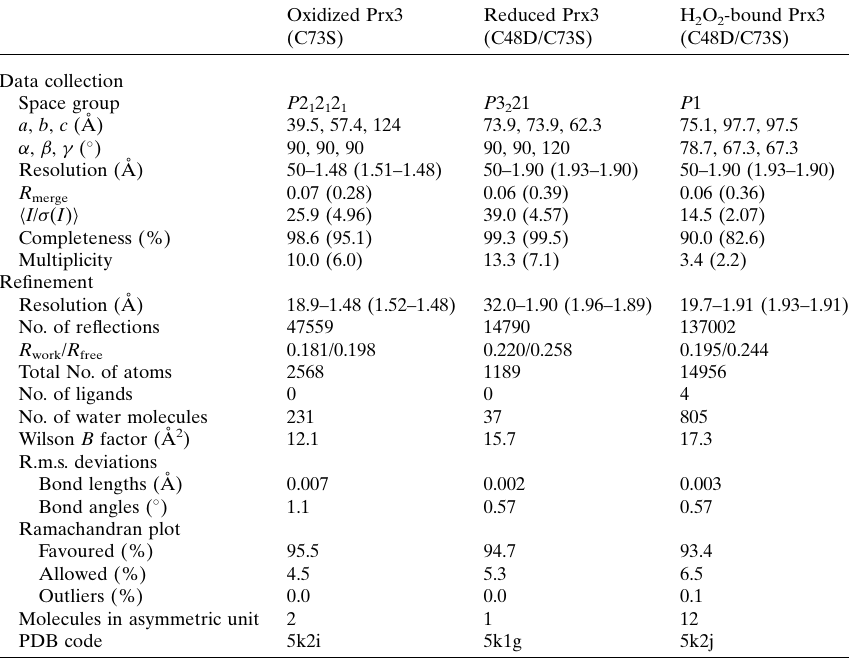
Table 1 Data-collection and refinement statistics. Values in parentheses are for the highest resolution